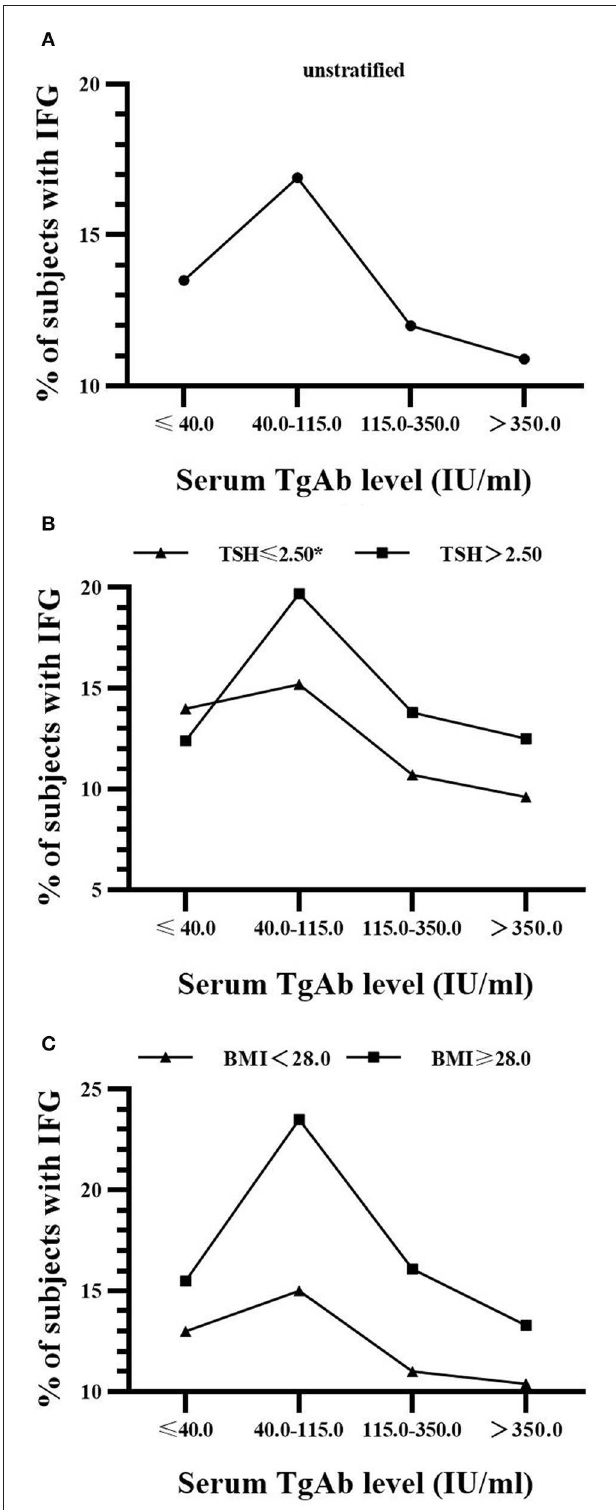
FIGURE 2 | Serum TgAb level and the percentage of subjects with IFG in men (A) Serum TgAb level and the percentage of subjects with IFG in all males.